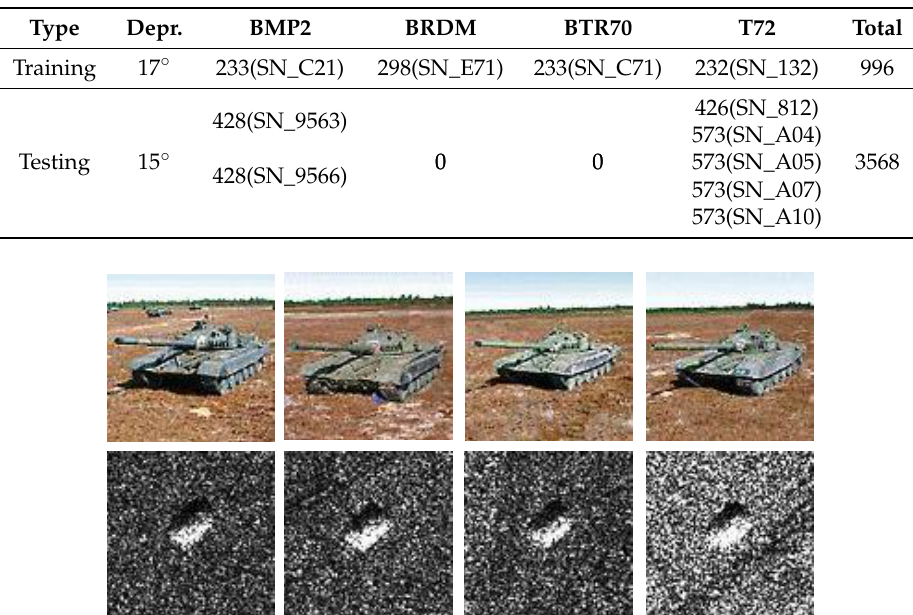
Table 7. The training and testing samples in the configuration variance EOC-2 experiments.